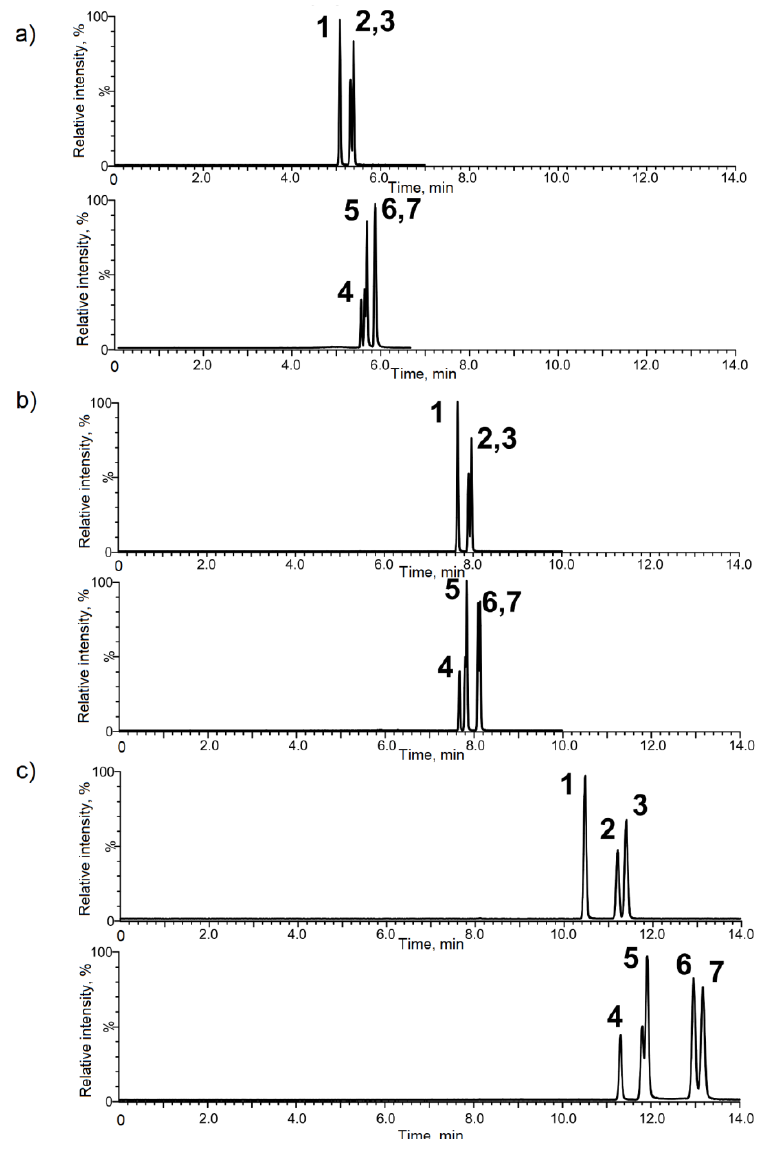
Figure 1. Optimization of the HPLC separation of metabolite position isomers of the toluic and methylbenzylsuccinic acids. 1 — o -toluic acid, 2 — m -toluic acid, 3 — p -toluic acid, 4 — 2-(1-phenylethyl)-succinic acid, 5—2-(2-methylbenzyl)succinic acid, 6—2-(3-methylbenzyl)succinic acid, and 7—2-(2-methylbenzyl)succinic acid). Acetic acid concentration in the mobile phase: ( a ) 0.05 %, ( b ) 0.1 %,